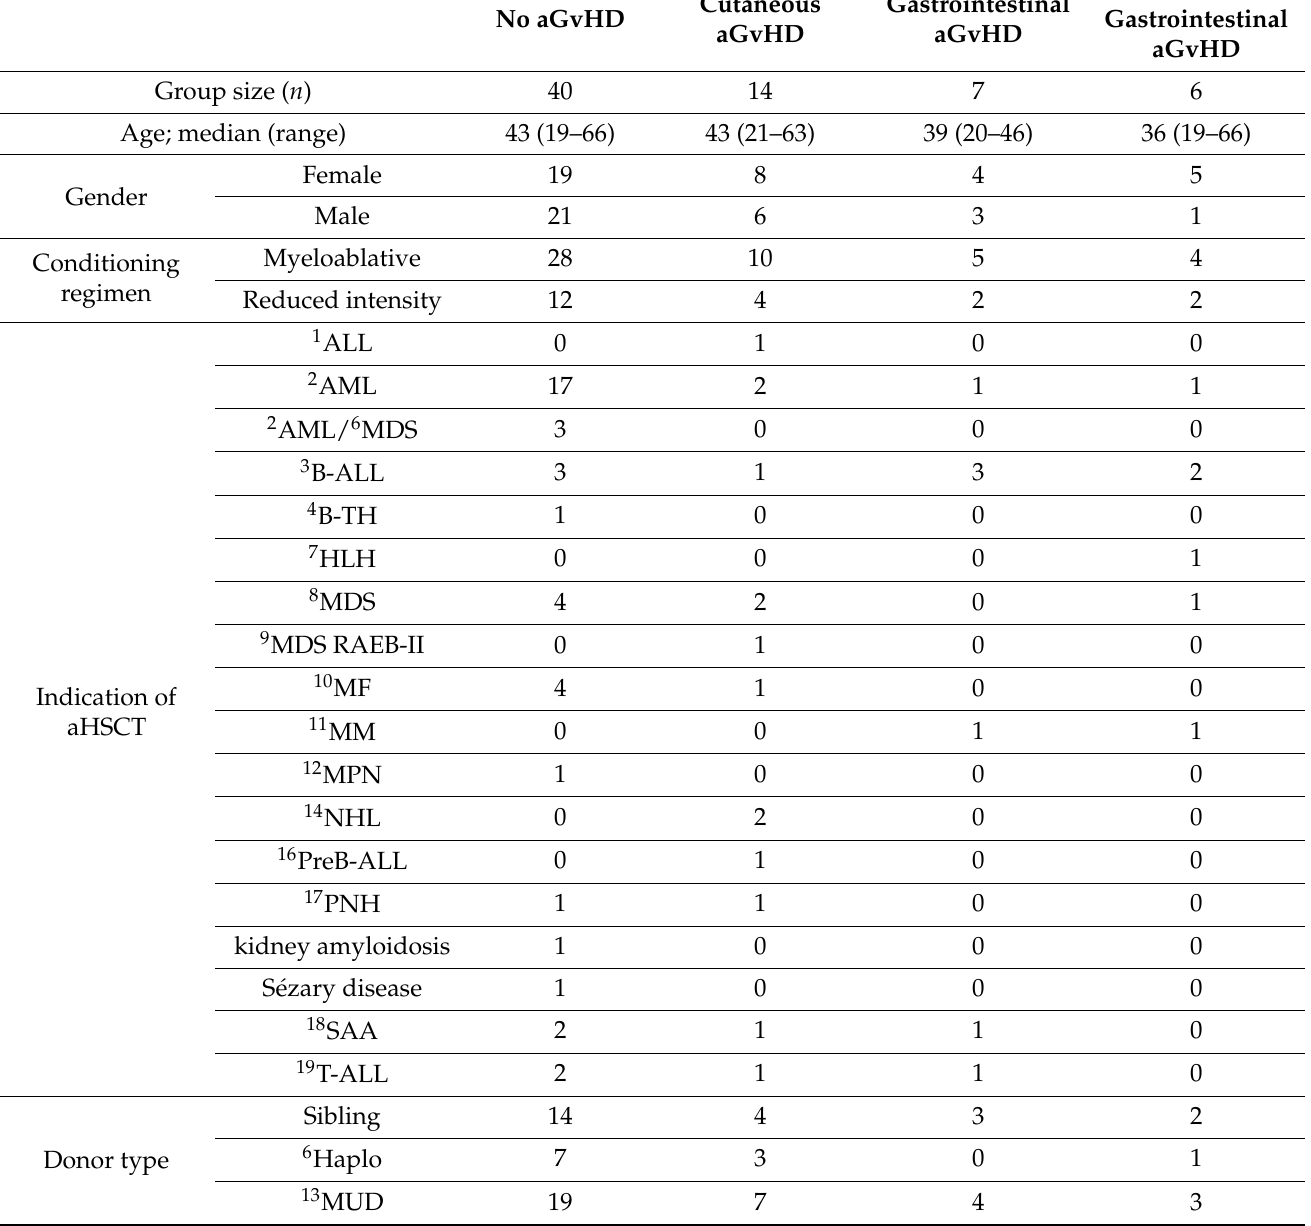
Table 2. Validation set, summary of patient data. Summarized patient data describing the validation set according to age, gender, conditioning regimen, indication and outcome of aHSCT, donor-recipient relationship, HLA match, aGvHD developed, type and extent of organ involvement, disease severity (grade). List of abbreviations: 1 ALL, acute lymphoblastic leukemia; 2 AML, acute myeloid leukemia; 2 AML/ 6 MDS, acute myeloid leukemia/myelodysplastic syndrome; 3 B-ALL, acute B lymphoblas- tic leukemia; 4 B-TH, beta thalassemia; 5 CR, complete remission; 6 Haplo, haploidentical